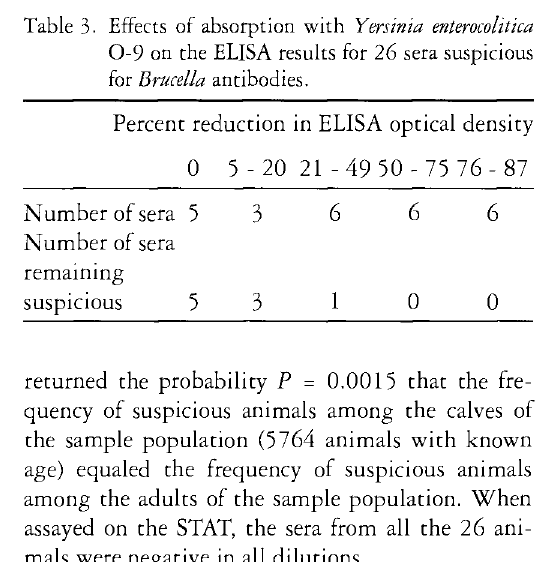
Table 3- Effects of absorption with Yersinia enterocolitica 0-9 on the ELISA results for 26 sera suspicious for Brucella